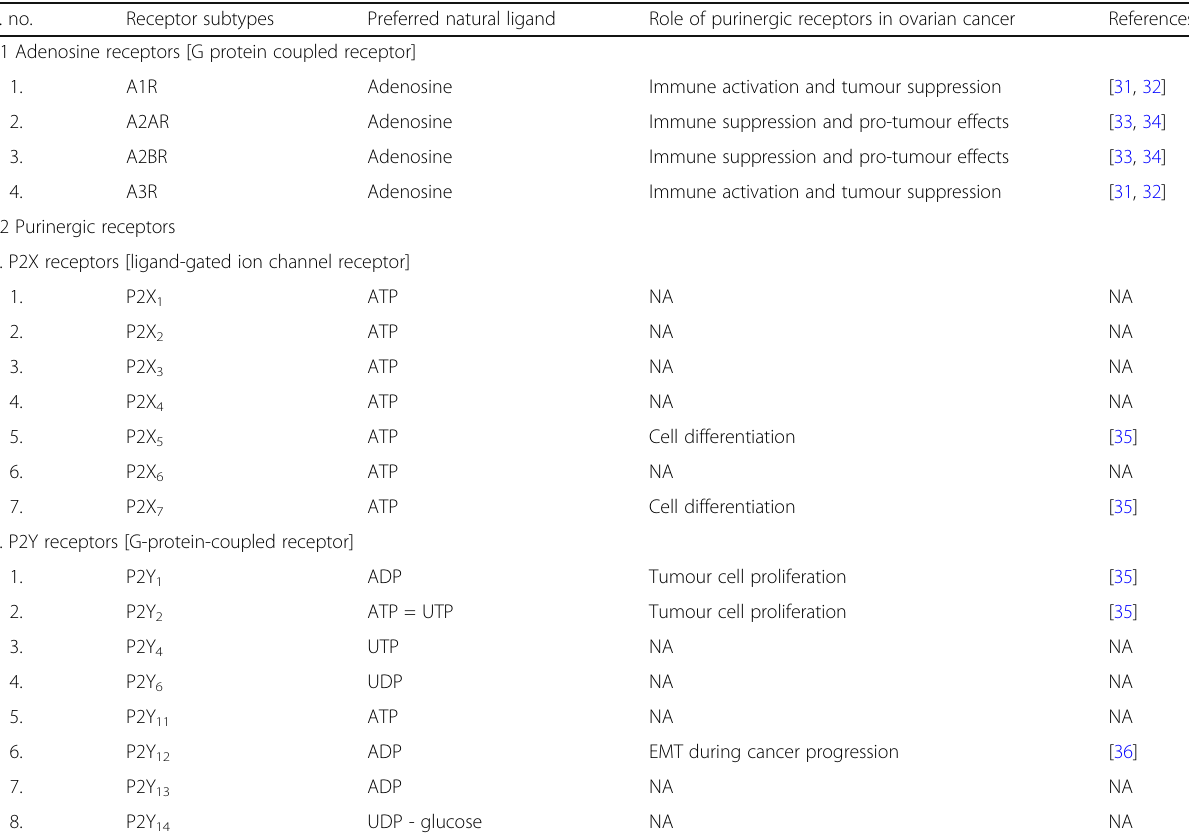
Table 1 Purinergic receptors in cancer S.